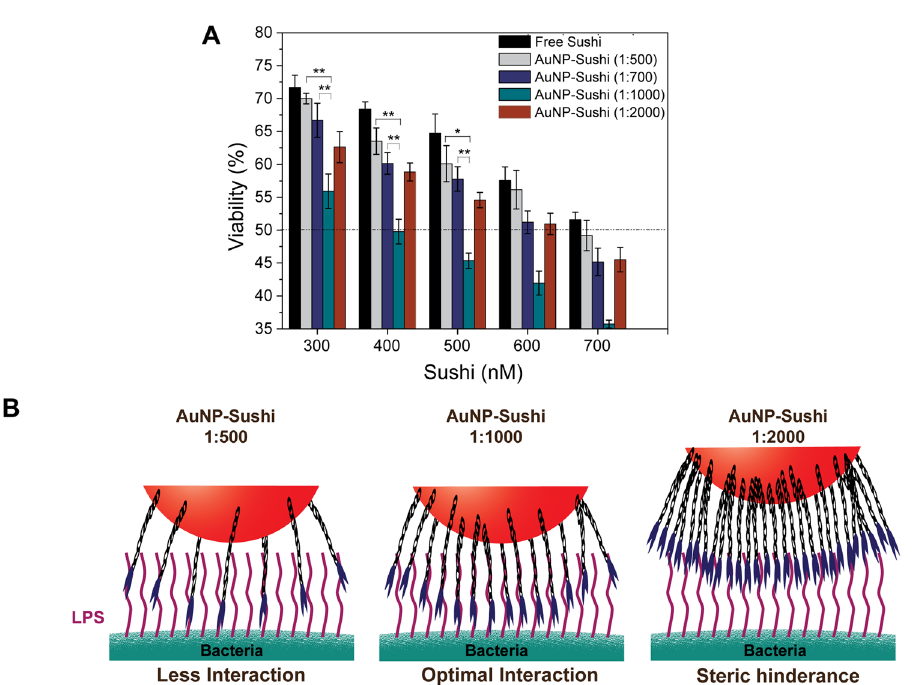
Figure 3. Antibacterial activity analysis of AuNP conjugates with S. typhi ( A ) NP-sushi conjugates are superior to free drug at all concentrations especially at 1:1000 molar ratio that gives ∼ 42% reduction in IC 50 value. (Two way ANOVA, ** P < 0.01, * P < 0.05). ( C ) Proposed model for NP-sushi and bacterial LPS